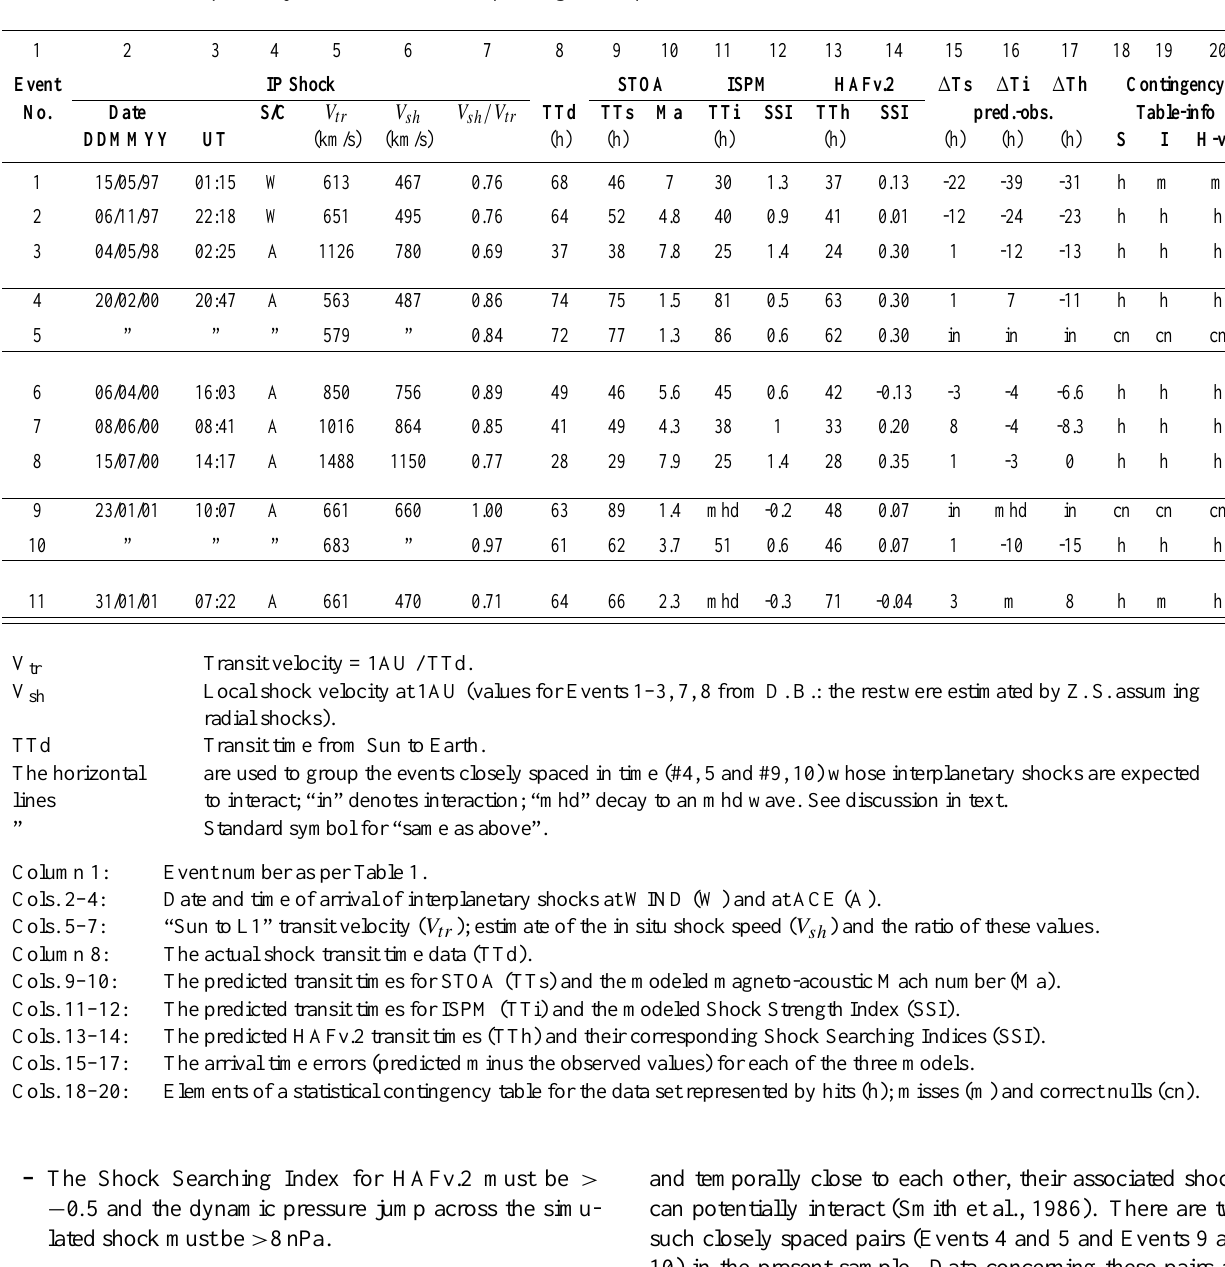
Table 2. Observed interplanetary shocks and the corresponding arrival predictions of three numerical